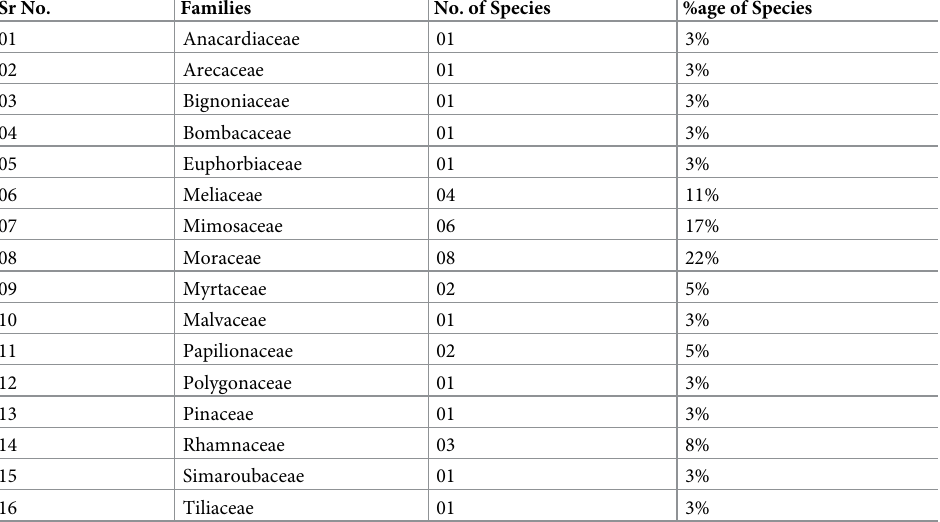
Table 1. Family index of trees of Shiwalik Mountain Range of District Bhimber Azad Jammu and Kashmir, Pakistan. Sr No.